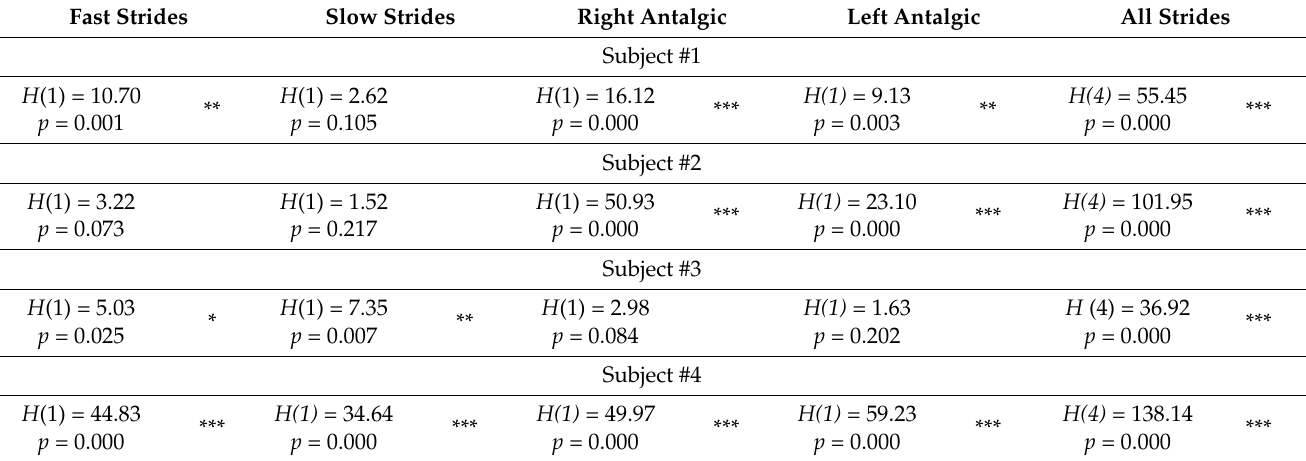
Table 7. Detection of Abnormal or Irregular Strides Using Leg Gap (Kruskal–Wallis test, with outliers removed). Fast Strides Slow Strides Right Antalgic Left Antalgic All Strides Subject #1